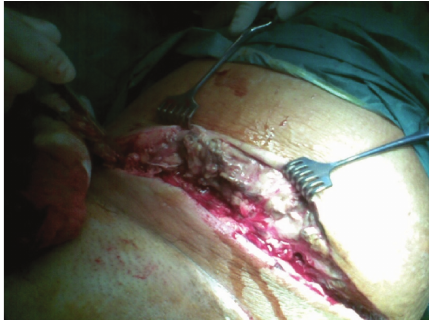
Figure 3: Extensive surgical incision required for initial debride- ment of necrotizing soft tissue